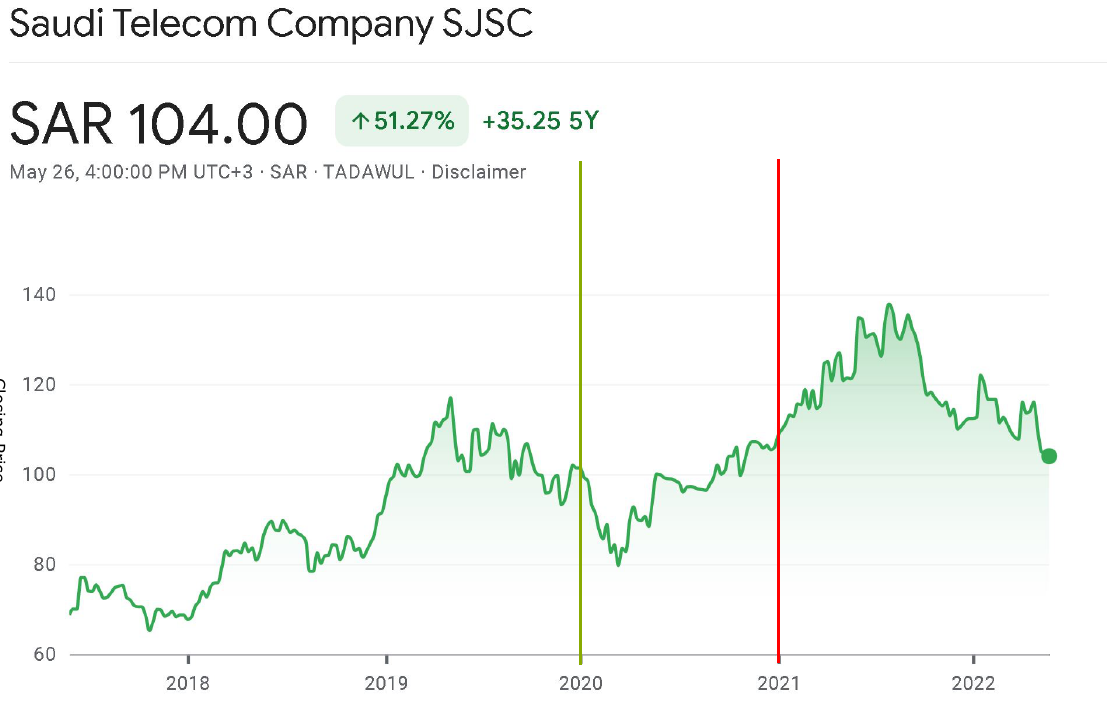
Figure 5. Behaviour of Saudi Telecom Company (7010) during the training and testing